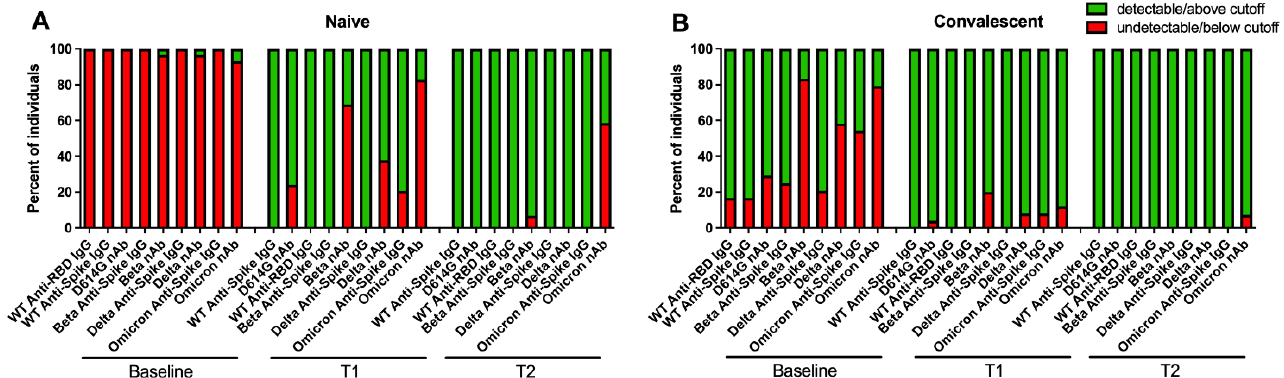
Figure 3. Percentage of individuals below the cutoff values or limit of detection for each SARS-CoV-2 antibody test in naive individuals ( A ) and in convalescent individuals ( B ). The cutoff was at 17.66 BAU/mL and 7.1 BAU/mL for the anti-spike IgG assay and the Anti-RBD IgG assay, respectively. The limit of detection (LoD) of Pseudovirus Neutralization assay was at ID50 of 20. Red bars represent the percentage of individuals below the cutoff or limit of detection. Green bars represent the percentage of individuals above the cutoff or limit of detection.